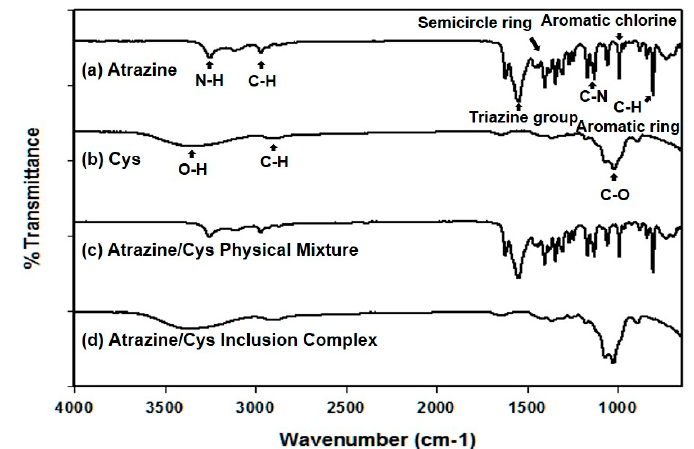
Figure 3. Job’s plot for atrazine and Cys.